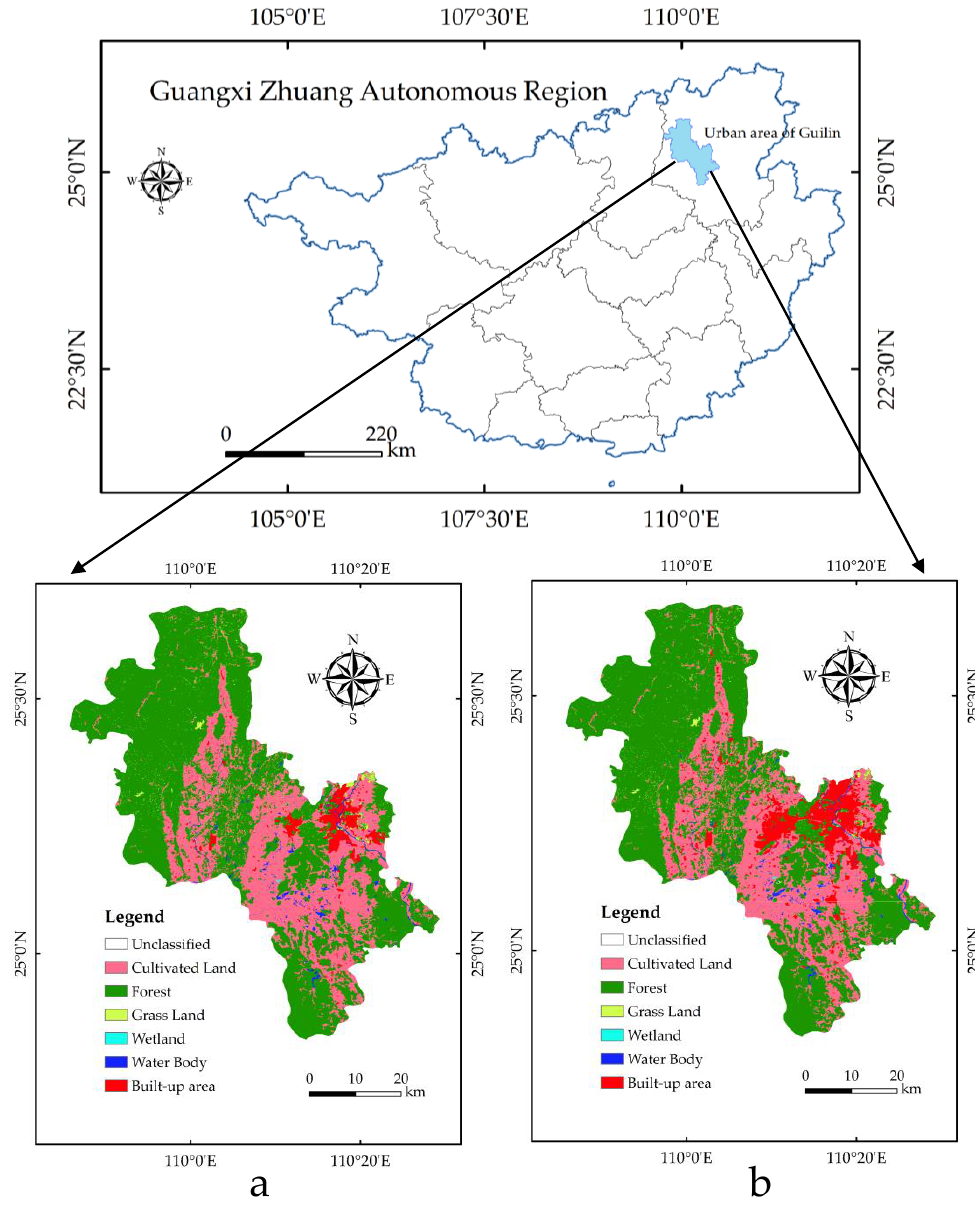
Figure 1. Land type map of the study area. ( a ) is the land type map of the study area in 2010. ( b ) is the land type map of the study area in 2020. Data source: National Geographic Information Resource Directory Service System (https://www.webmap.cn/main.do?method=index (accessed on 15 September 2022)).